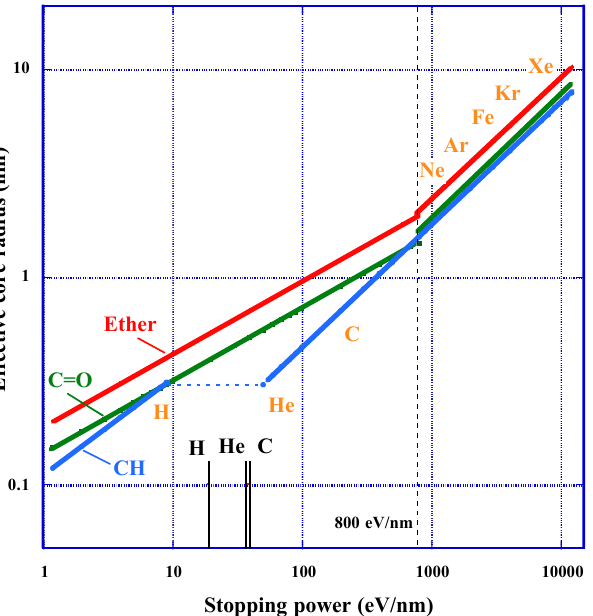
Figure 7. Effective track core radius for losses of ether, carbonate ester and CH groups .